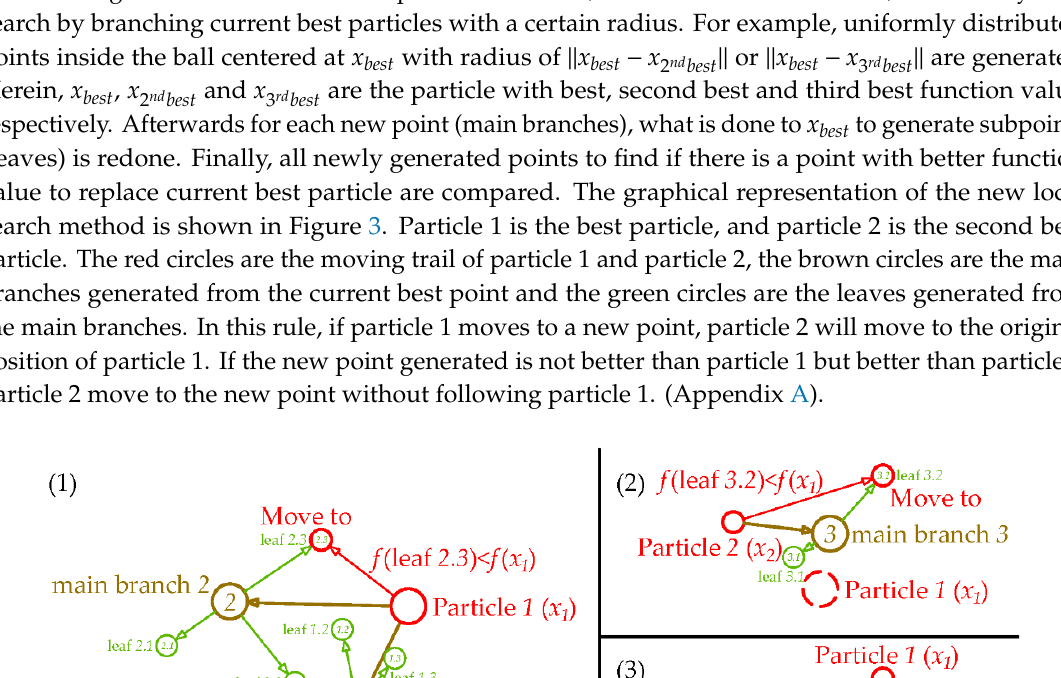
Figure 4. Graphical representation of new movement rule.